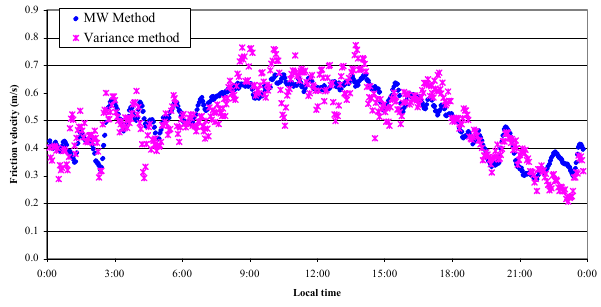
Fig. 7b. Friction velocity. Comparison between the statistical Figure 7.b: Friction velocity. Comparison between the statistical method MW and the variance method (Plot RT, 25 July 1997) method MW and the variance method (Plot RT, 25 July 1997).